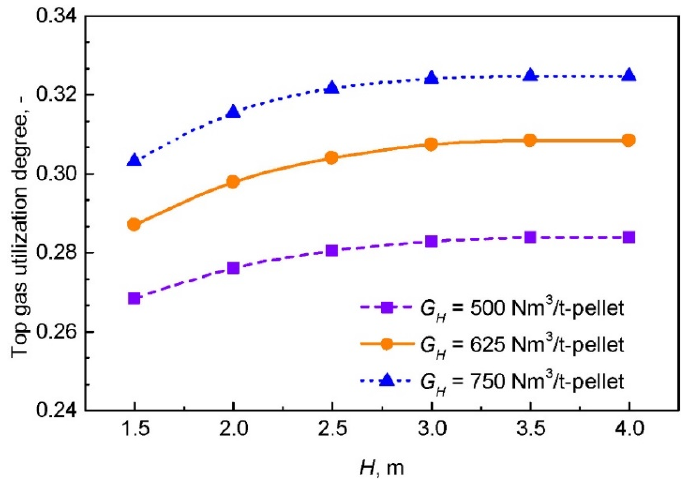
Figure 3. Effect of upper-row injection distance ( H ) on top gas utilization degree at different injection rates ( G H ).